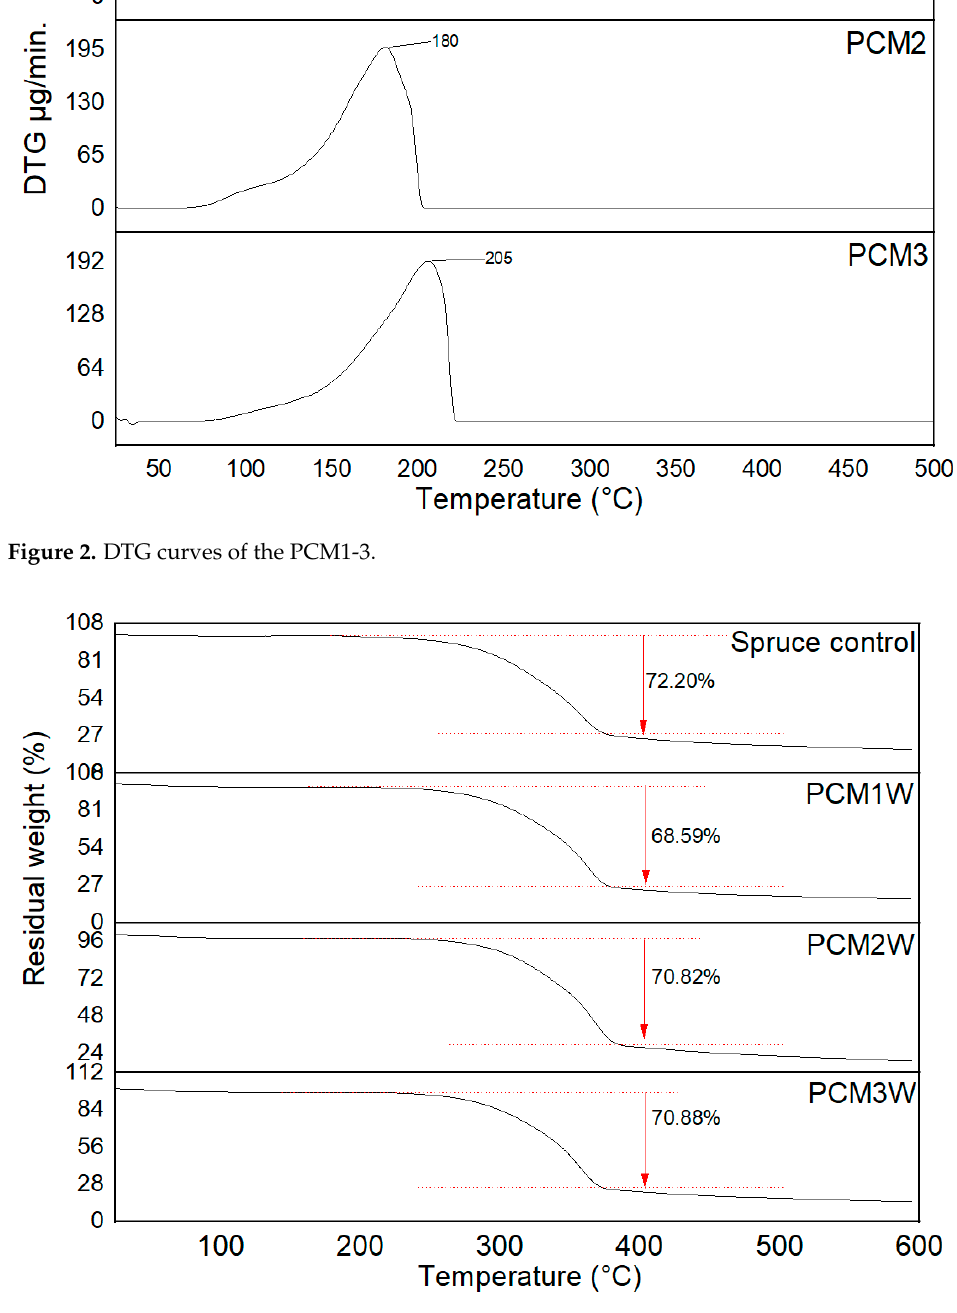
Figure 3. TGA curves of the PCMW1-3.